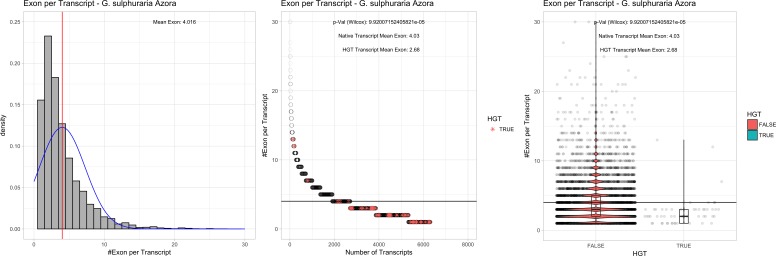
Exon/Intron – Galdieria sulphuraria Azora: (Left) Mid) Cumulative %GC distribution of transcripts.Red line shows the average, blue line a normal distribution based on the average value. The data is categorical (genes have either one, two, three etc. exons) and does not follow a normal distribution. (Mid) Ranking all transcripts based upon their number of exons. Red ‘*' demarks HGT candidates. As the number of exons was not normally distributed, transcripts were ranked by number of exons. In order to resolve the high number of tied ranks (e.g. many transcripts have two exons) a bootstrap was implied by which the rank of transcripts sharing the same number of exons was randomly assigned 1000 times. Wilcoxon-Mann-Whitney-Test applied for the determination of significant rank differences between the native gene and the HGT candidate subset. (Right) Violin plot showing the number of exons per transcript distribution across native transcripts and HGT candidates.